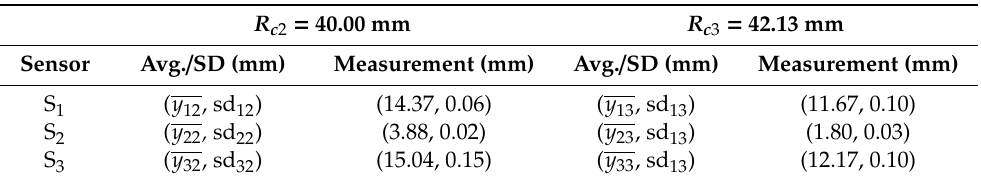
Table 10. Displacements of the inspected part whose nominal radius is priory known 𝑅 (cid:3032) = 41.03 mm, Table 9. Displacements of the calibration master measured at two radii by using displacement sensors measured with an accuracy of ± 0.01 mm. with ± 0.01 mm accuracy.